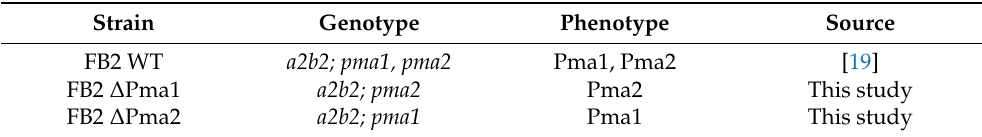
Table 1. Ustilago maydis strains used in this